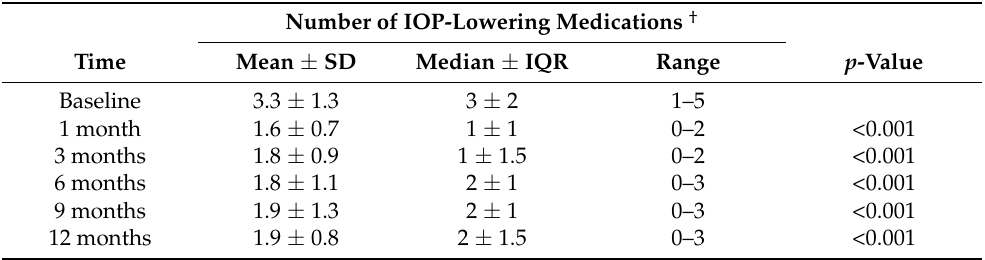
Table 3. The number of IOP-lowering medications used at various postoperative time points com- pared to the baseline.